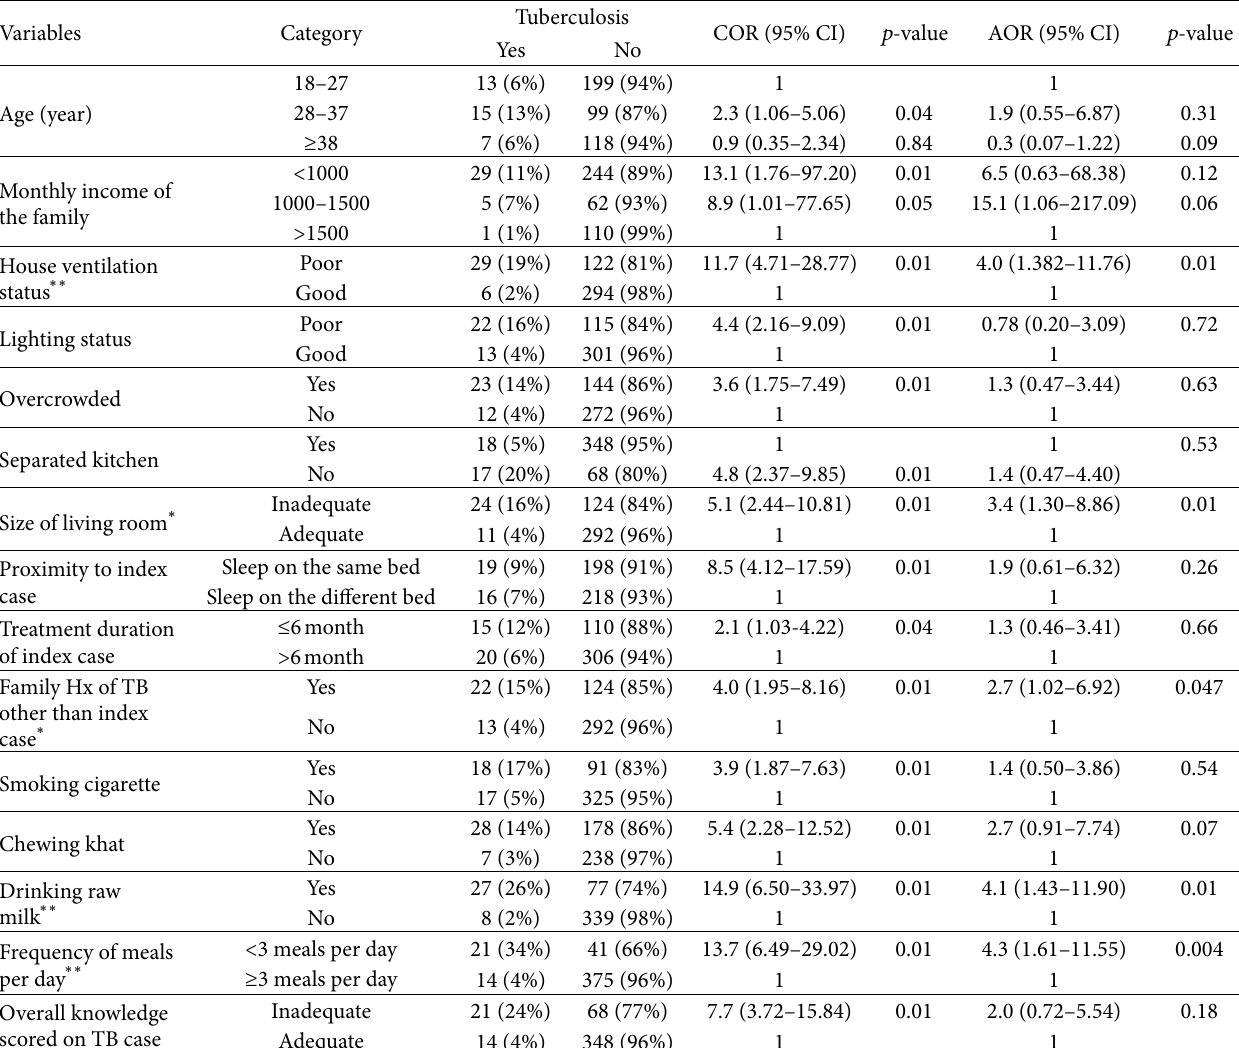
Table 4: Factors associated with Tuberculosis disease among adult household contacts of smear positive PTB patients in Haramaya district, Eastern Ethiopia, 2019 ( 푛 = 451